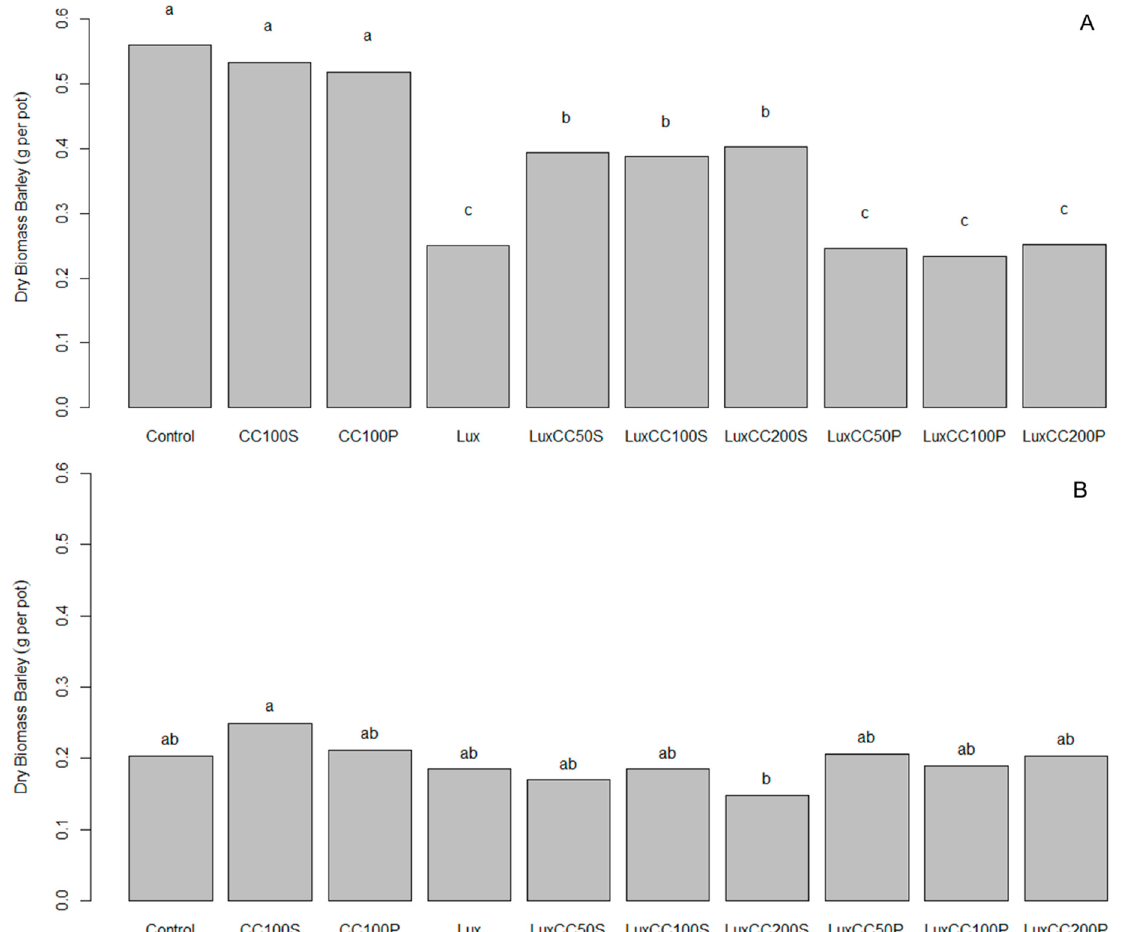
Figure 8. Winter barley biomass (g pot − 1 ) in response to post-emergence application of Luximo (Lux) and ComCat (CC) as seed (S) and co-formulated post-emergence (P) applications at 50, 100, and 200 g ha − 1 at Hohenheim 2021, 21 and 27 days after sowing in the experiments ( A , B ). A rate of 100 g ha − 1 corresponds to the recommended field rate. Means with identical letters above the columns graph do not differ significantly based on Tukey’s HSD test ( p ≤ 0.05).